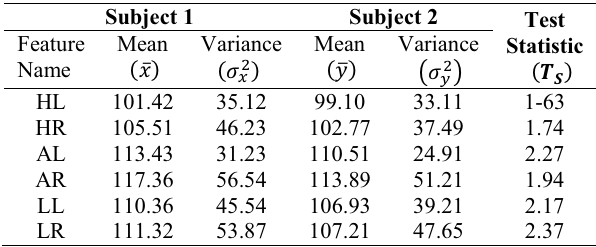
Table 4. Descriptive statistics of features for polygon